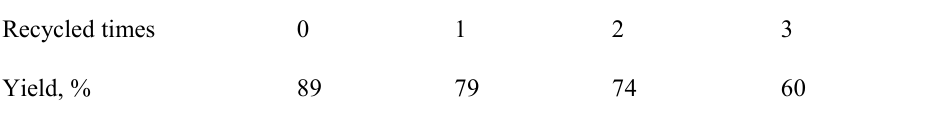
Table 5 The effect of recycled times of ACC/silica gel on the oxidation of cyclohexanol to adipic acid under ultrasound irradiation